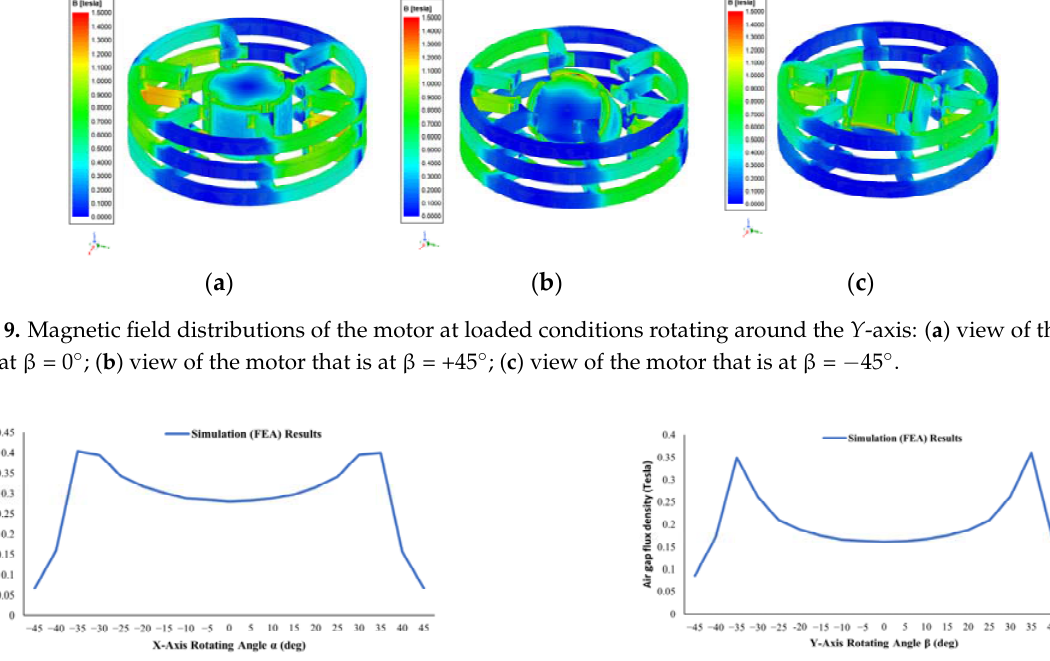
Figure 9. Magnetic field distributions of the motor at loaded conditions rotating around the Y ‐ axis: ( a ) view of the motor that is at β = 0°; ( b ) view of the motor that is at β = +45°; ( c ) view of the motor that is at β = –45°.